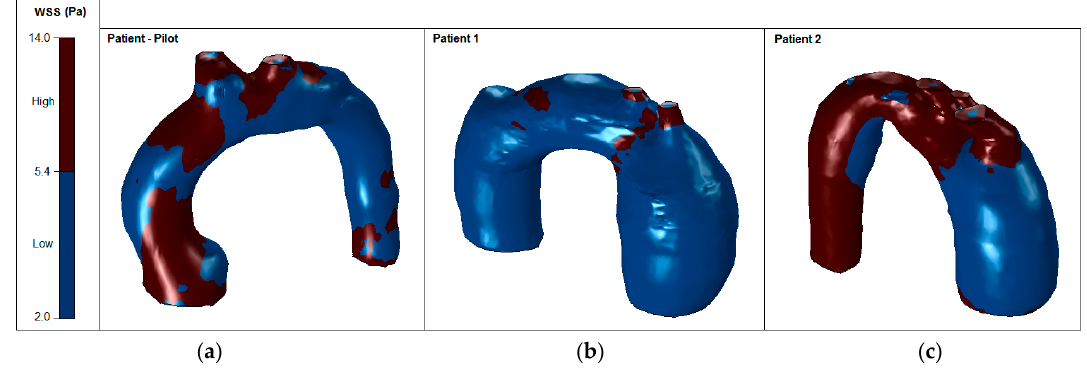
Figure 17. High and low WSS at peak systole: (a) Patient-pilot; (b) Patient 1; (c) Patient